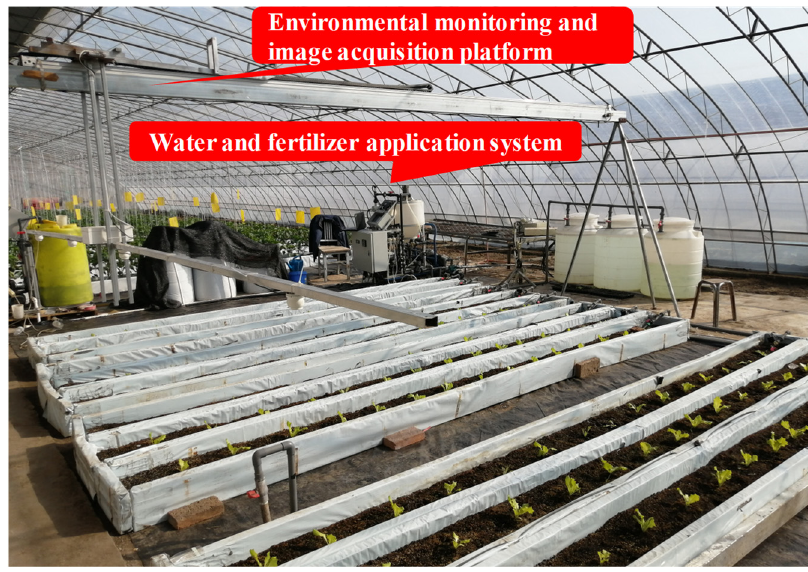
Figure 1. Lettuce cultivation experiment.